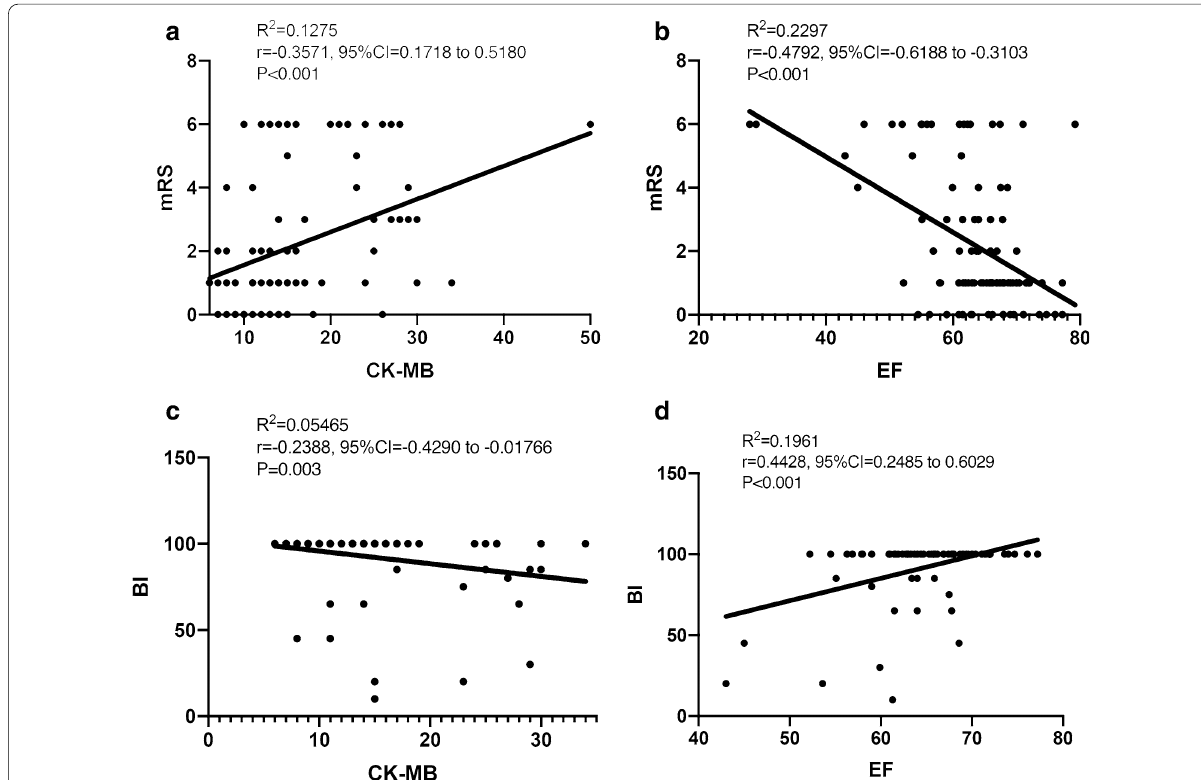
Fig. 1 Correlation between cardiac parameters and prognosis of non‑LAA patients. Non-LAA non‑large artery atherosclerosis